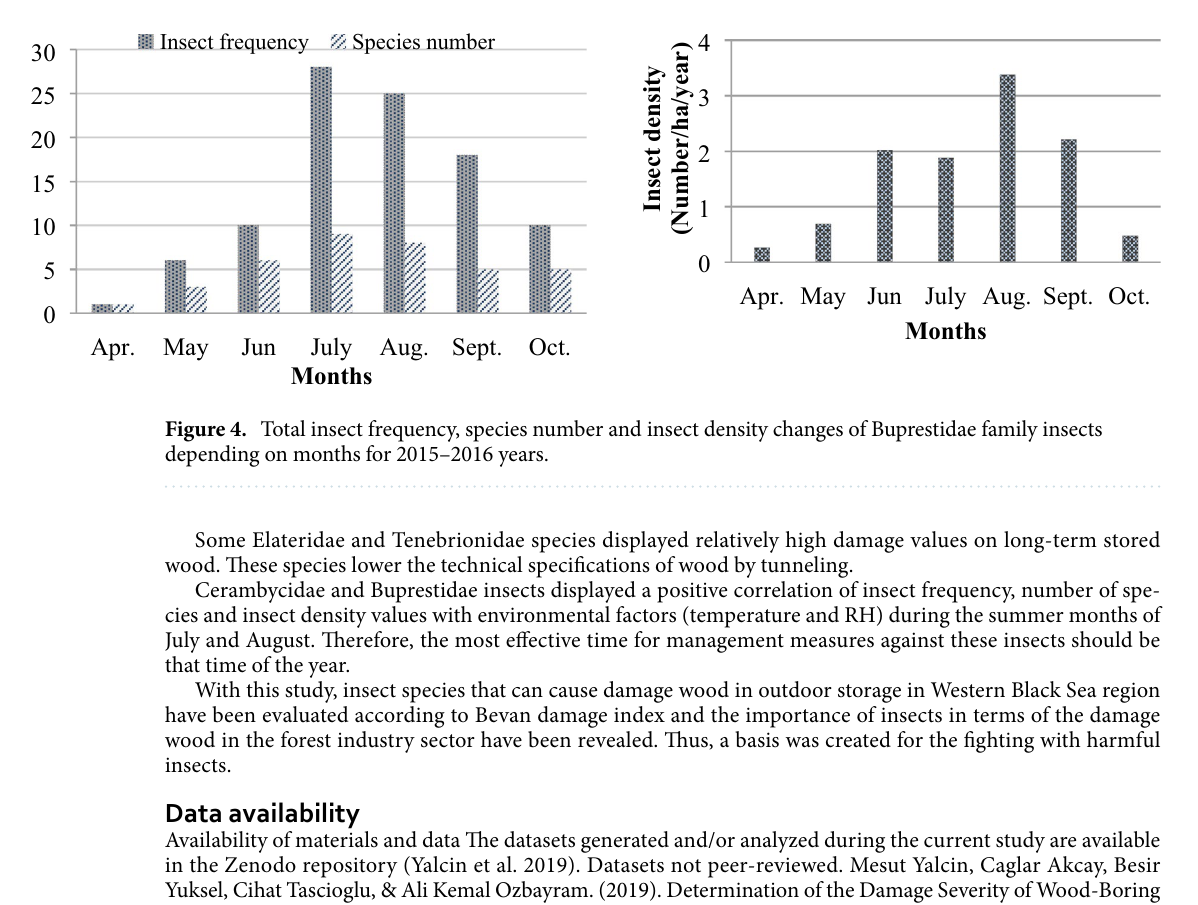
Figure 3. Total insect frequency, species number and insect density changes of the species of Cerambycidae family depending on months for 2015–2016 years.